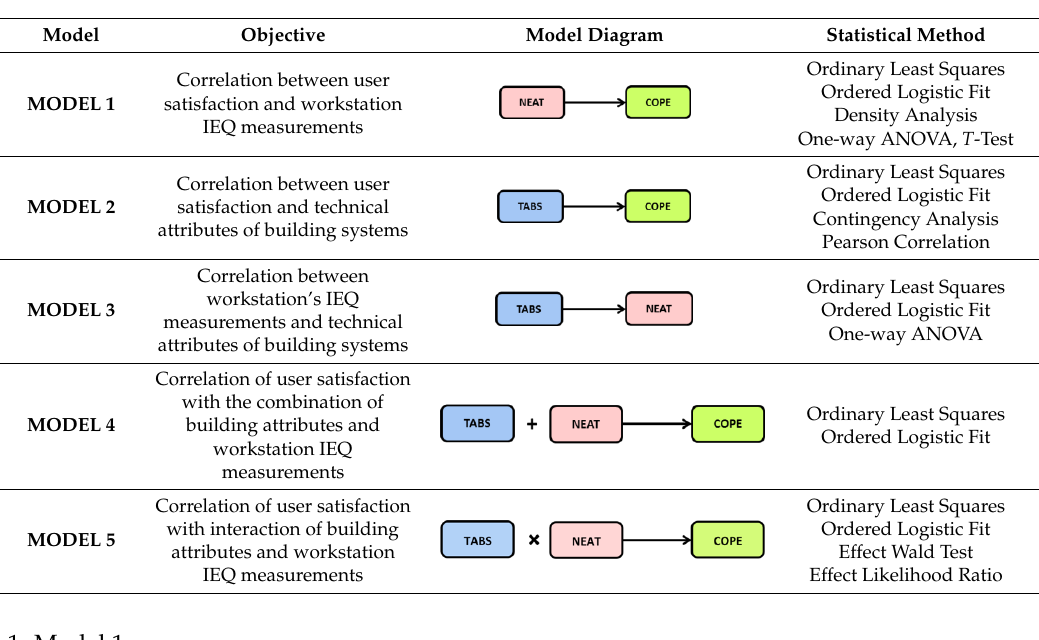
Table 5. Objectives of five models and each diagram.